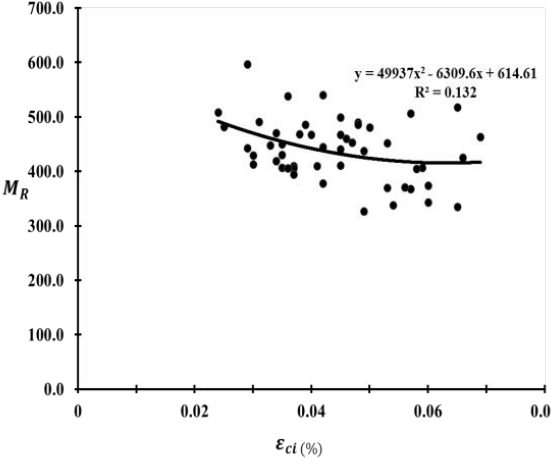
and crack initiation strain ( e R ) ci